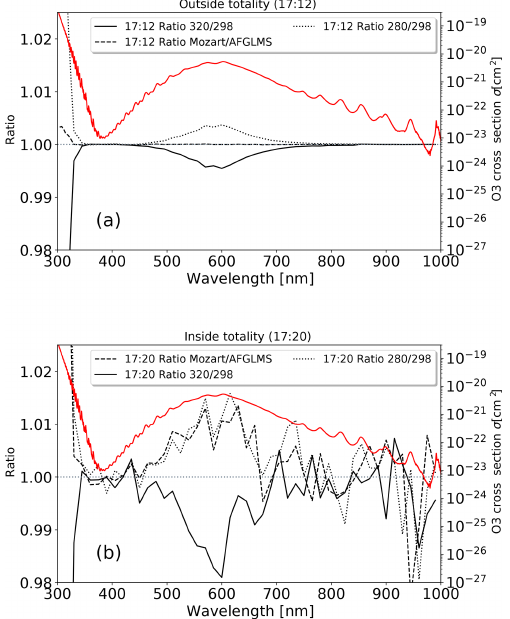
Figure 11. Simulated irradiance for a partial eclipse (a) and total- ity (b) for different wavelengths, normalized to the irradiance at the corresponding wavelength with the midlatitude summer profile scaled to 298DU TOC. The solid line corresponds to an increase to 320DU TOC, and the dotted line to a decrease to 280DU TOC. For the dashed line, the TOC was kept constant to 298DU TOC, but the midlatitude summer profile was replaced with the one from MOZART. The position of 1 . 0 is indicated by a coordinate line for better readability. The red curve shows the total ozone absorption cross section and corresponds with values on the right y axis. For 304nm, changes are ± 20% outside totality and ± 30% inside (not